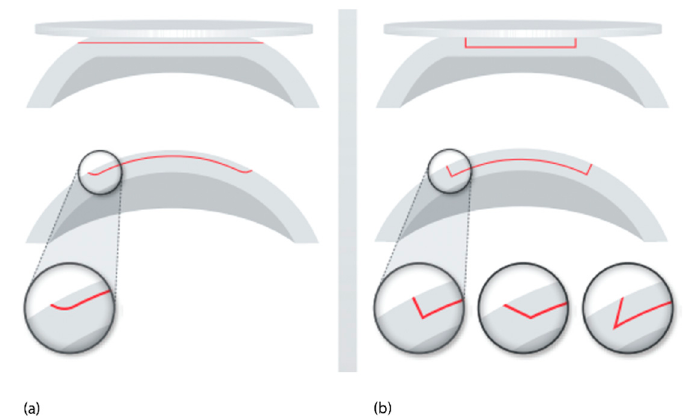
Figure 10. Corneal flaps cut by fs laser: ( a ) straight plane (red) with continuously curved sides cut during vacuum docking to a flat interface, ( b ) angulated side cut options (3D cutting